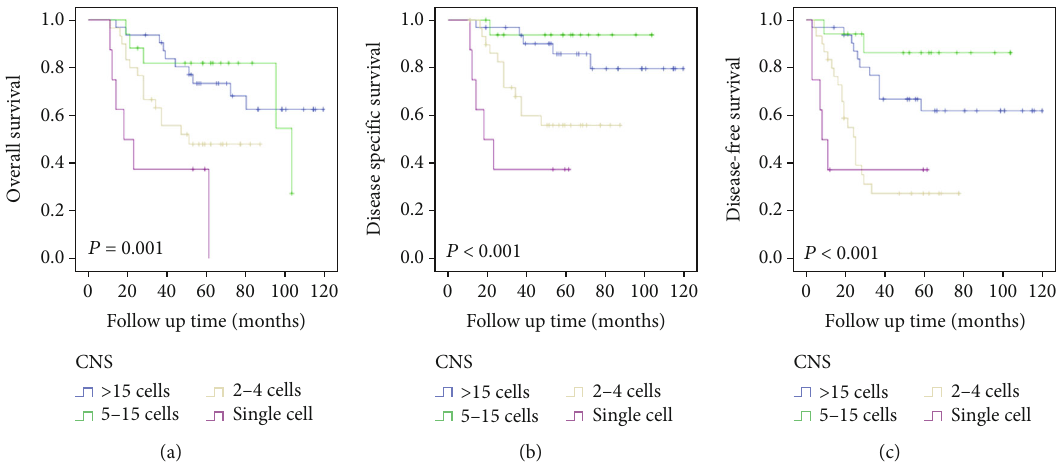
Figure 3: Association of the cell nest size with overall survival (a), disease-speci fi c survival (b), and disease-free survival (c), in ureter urothelial carcinoma.